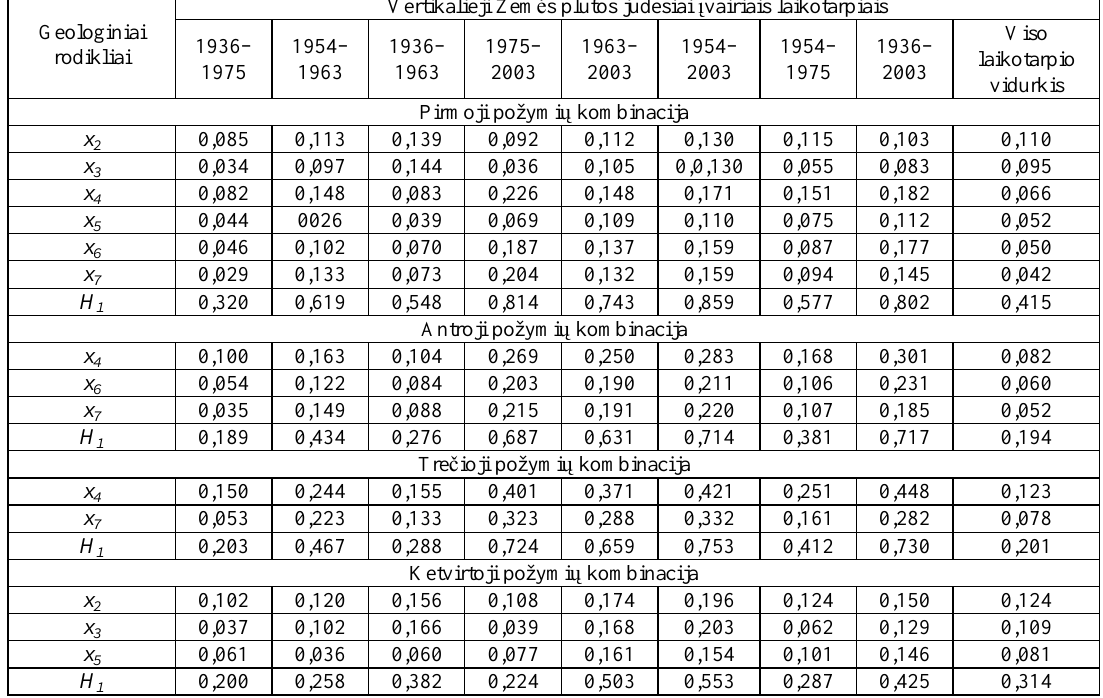
Table 3. The comparative informative rating of geological factors accounting to reversed Lithuania seaside